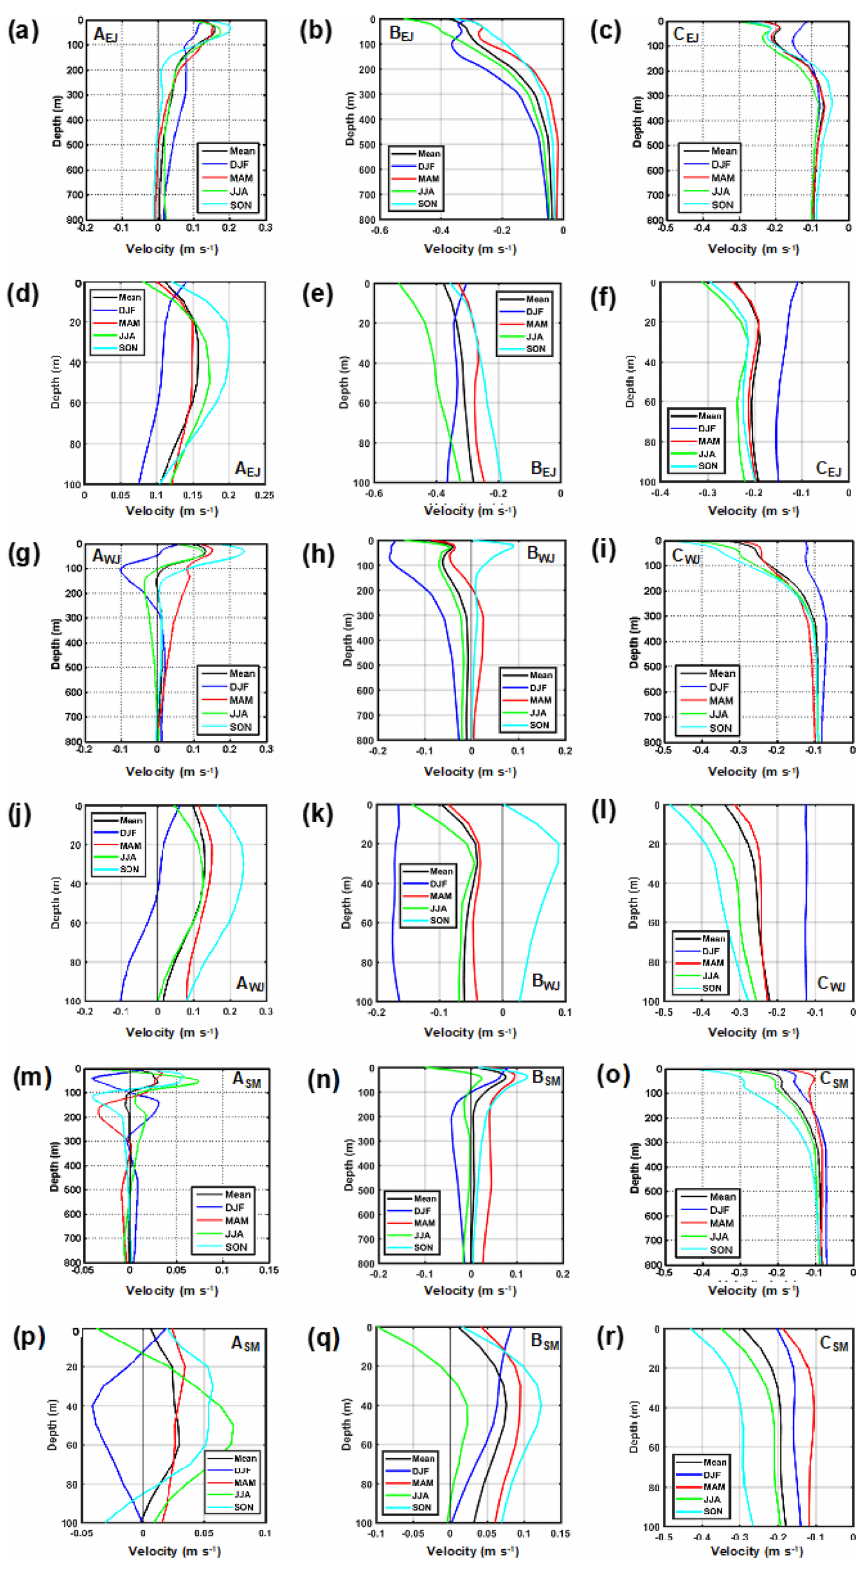
Figure 6. Mean and seasonal profiles of zonal current velocity derived from the HYCOM simulation results for the period of 1950 through 2013 at the following points: (a) A EJ , (b) B EJ , (c) C EJ , (g) A WJ , (h) B WJ , (i) C WJ , (m) A SM , (n) B SM , and (o) C SM . Meanwhile, (d) – (f) , (j) – (l) , and (p) – (r) are the same as (a) – (c) , (g) – (i) , and (m) – (o) , respectively, except provide results for depths of 0–100m. Ocean Sci., 17, 1115–1140, 2021